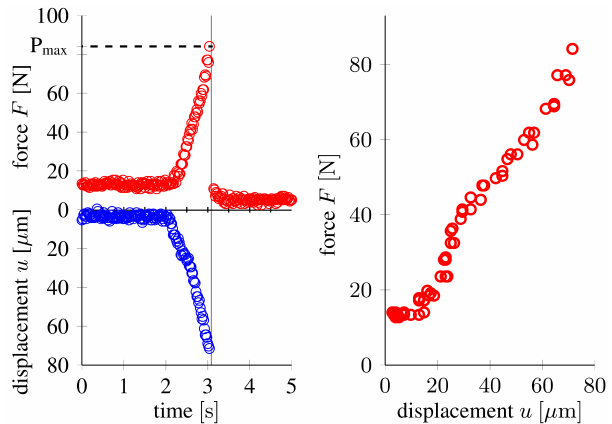
Figure 3. Location of the examined ice core B34. Figure 6. Representative microstructure of the B 34 ice core show- ing air bubbles (black inclusions), grain boundaries (black lines) and the examplary white line, where the grain size was measured.